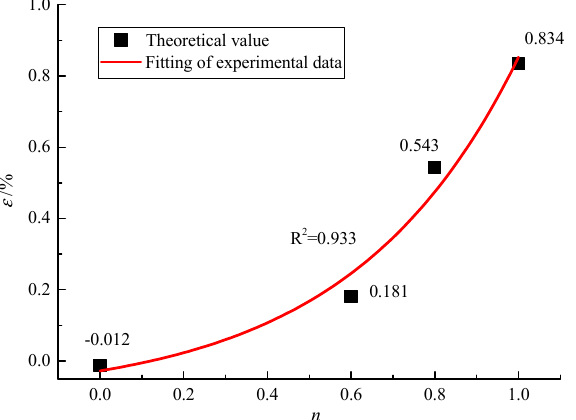
Figure 17. The relationship between the maximum generalized strain at the crack tip and the initial moisture content of the crack ( n 0 ).